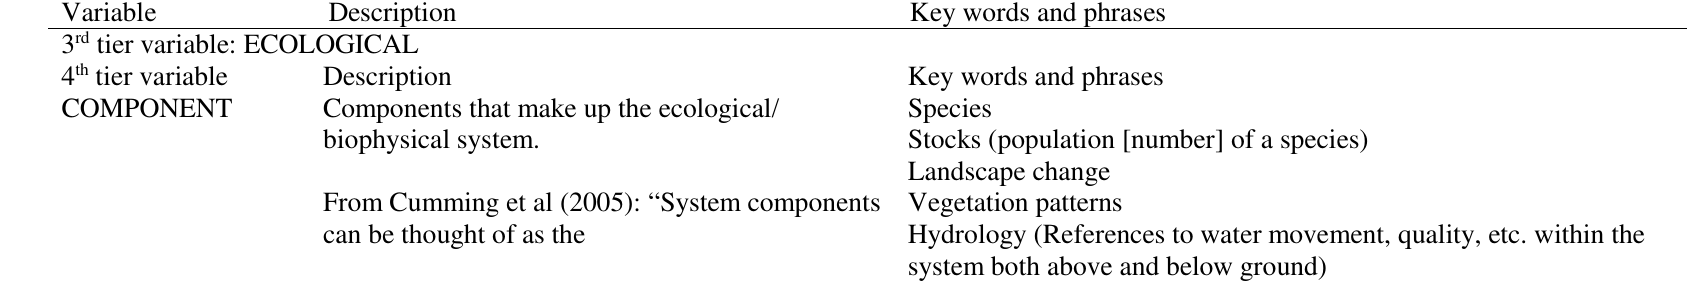
Table A5.4 Adapted from Plummer and Armitage (2007) and others where noted.